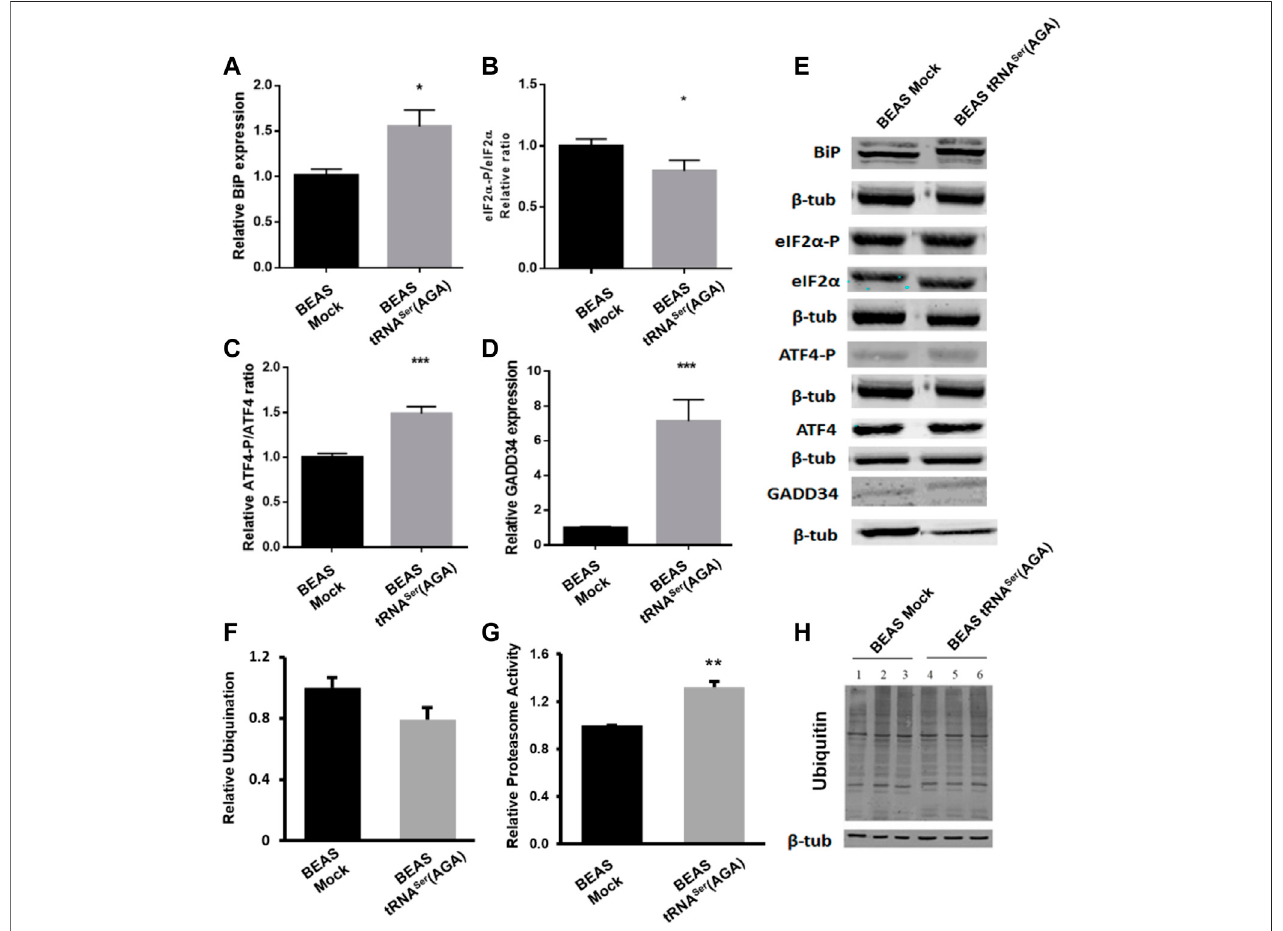
FIGURE 2 | UPR and UPS deregulation induced by recombinant tRNASer(AGA). (A) Expression of tRNA Ser (AGA) increases BiP expression in BEAS-2B cells. (B) LevelsofeIF2 α -PweredecreasedincellswithtRNA Ser (AGA). (C) tRNASer(AGA)expressioninBEAS-2BcelllineincreasedtheactivationofATF4transcriptionfactor. (D) Expression of GADD34 was increased in BEAS-2B cells expressing the recombinant tRNA Ser (AGA). (E) Immunoblots using antibodies against BiP, eIF2 α -P, eIF2 α , ATF4-P, ATF4 and GADD34. B-tub served asprotein loading control. Graphics depict average ±SEM ( n = 3), with three technical replicates. (F) No differences are observed between BEAS-2B Mock and tRNA Ser (AGA) cells regarding ubiquitin levels. Graphic represents average ±SEM of fi ve independent experiments. (G) Upregulation of tRNA Ser (AGA) in BEAS-2B increases proteasome activity by 1.32-fold. Graphic depicts average ±SEM ( n = 4), with three technical replicates. (H) Expression of ubiquitin. ß -tubulin represents the internal control. Total protein was extracted from BEAS-2B Mock cells (lanes 1, 2 and 3) and BEAS-2B tRNA Ser (AGA) (lanes 4, 5 and 6). Image represents results from one independent experiment with all technical replicates. Data was analyzed with One-way ANOVA and Holm Sidak ’ s post-test and signi fi cant p values are shown (* p < 0.05; ** p < 0.01; *** p <